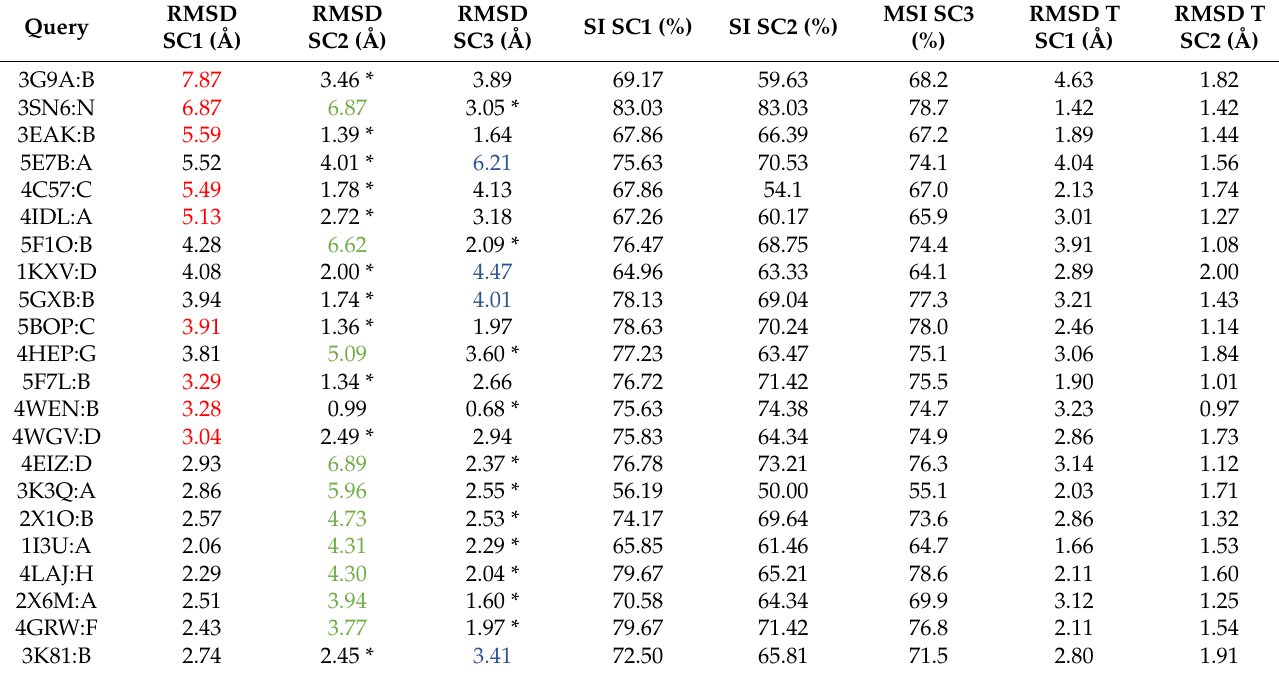
Table 1. Structural models with more than 3Å RMSD. Listed below are the PDB IDs and chain IDs of the V H H query (column 1) with corresponding RMSD values of DOPE score selected models for the three scenarios (columns 2 to 4), the sequence identity (or mean sequence identity for the multi-template case) with the structural template (columns 5 to 7, SI and MSI), and the RMSD with the structural templates for scenario 1 (column 8) and scenario 2 (column 9). The scenario in which the best model has the highest RMSD is marked in red for scenario 1, green for scenario 2, and blue for scenario 3. A ‘*’ indicates the lowest RMSD